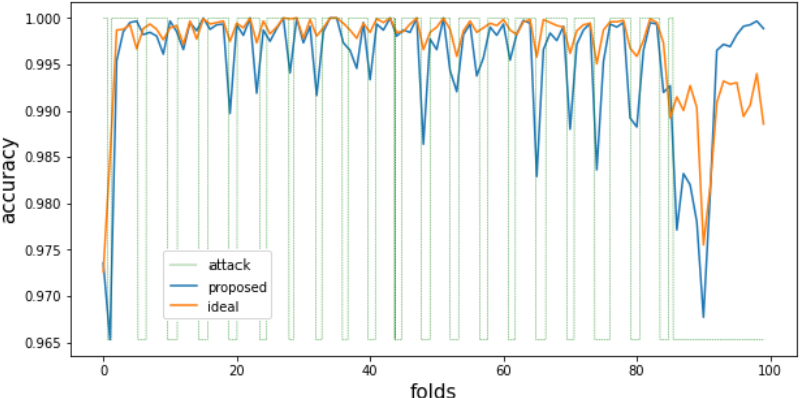
Figure 3. Attack classification accuracy of the proposed method and the ideal method when the size of the pure dataset is 20,000.